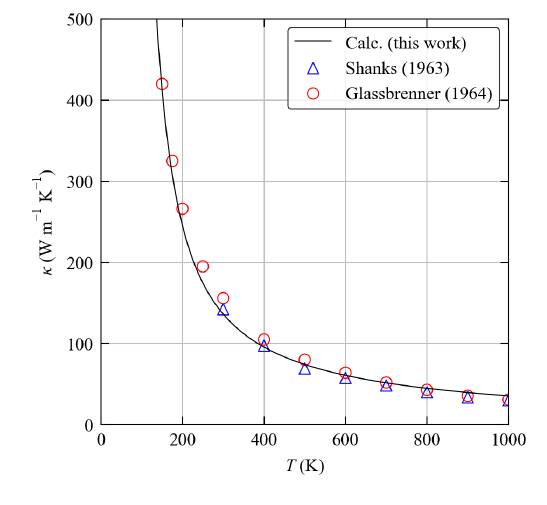
Figure 7. Calculated averaged lattice thermal conductivity of bulk diamond Si as a function of temperature (black line) compared to experimental data from Refs [30,31] (blue triangles/red